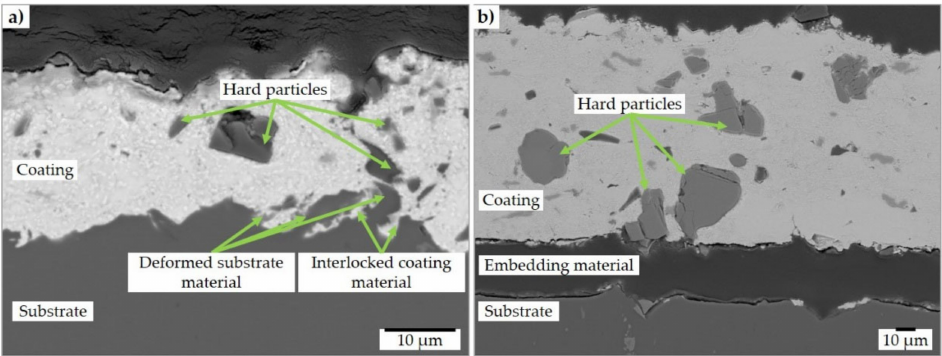
Figure 6. The interface between the substrate surface and the obtained coating: ( a ) coating produced using Al 2 O 3 METCO 6103 ( − 45 + 15 µ m), ( b ) coating produced using Al 2 O 3 Amperit 740.002 ( − 90 + 45 µ m).